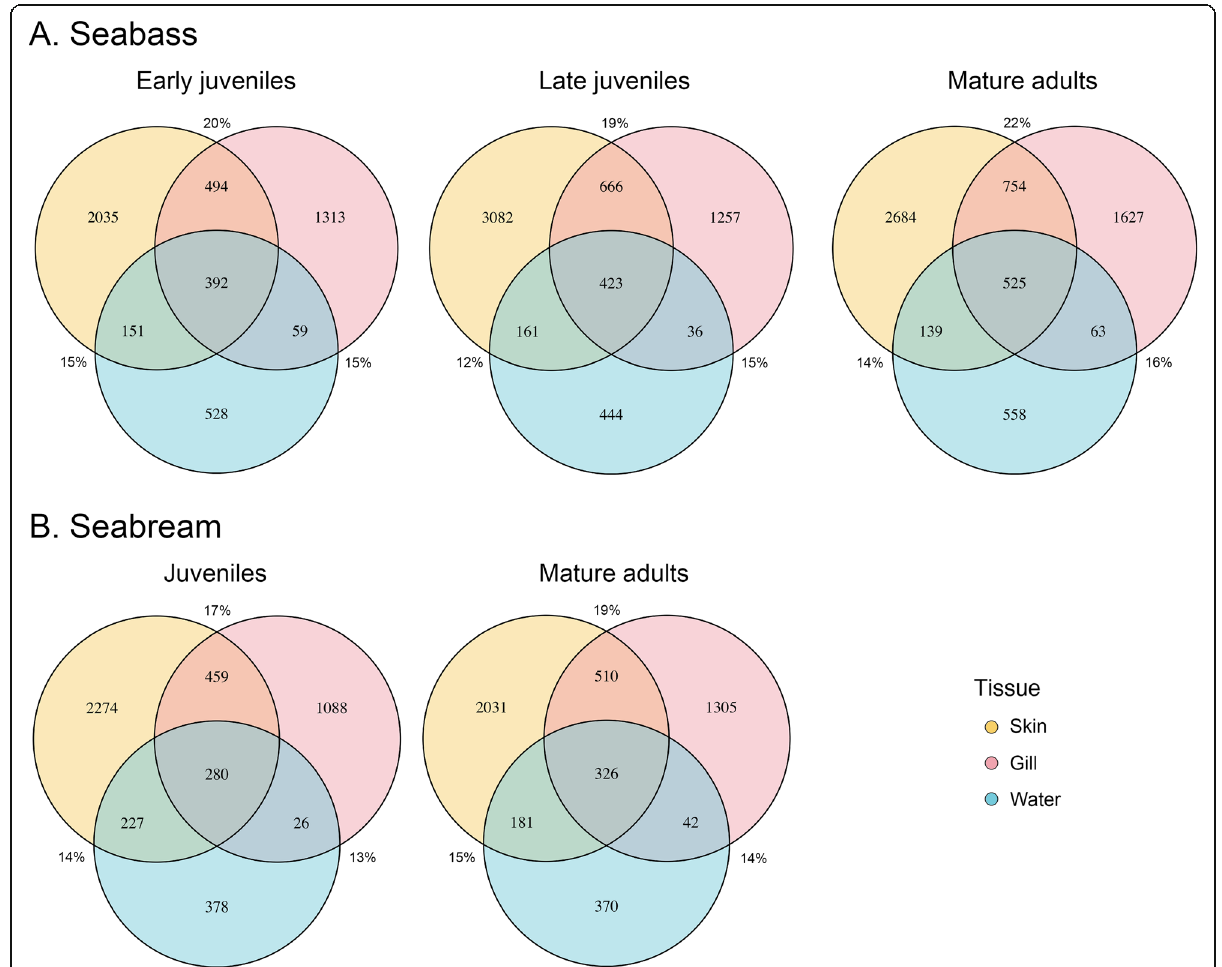
Fig. 5 Venn diagrams showing the number and percentage of shared ASVs between skin (yellow), gill (pink) and water (blue) microbiota of the different age groups for the seabass Dicentrarchus labrax ( a ) and the seabream Sparus aurata ( b ) ( n = 60 per species x age group for tissues; n = 10 per species x age group for